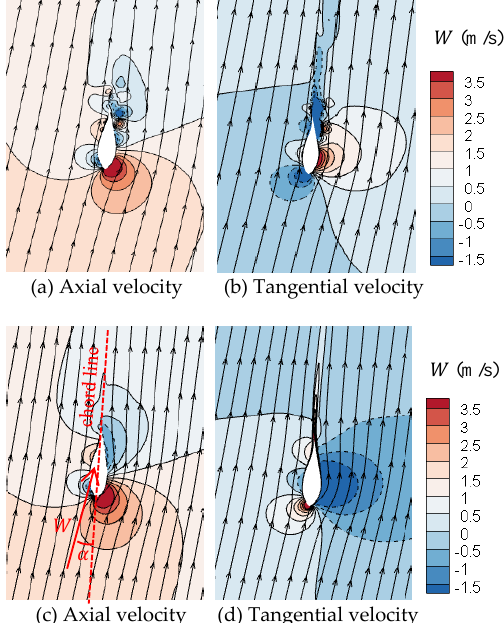
Fig. 8. Contour plots of axial and tangential velocities relative to the blade at r/R = 0.8 for a surging (a and b) and fixed (c and d) and turbine at 𝑡 𝑇 𝑅 ⁄ = 8.25, where 𝑈 𝑎𝑝 ≈ 𝑈 ∞ . Dashed lines indicate negative contour values. Streamlines of the resultant velocity 𝑊 are superimposed. 𝛼 is the instantaneous angle of attack.